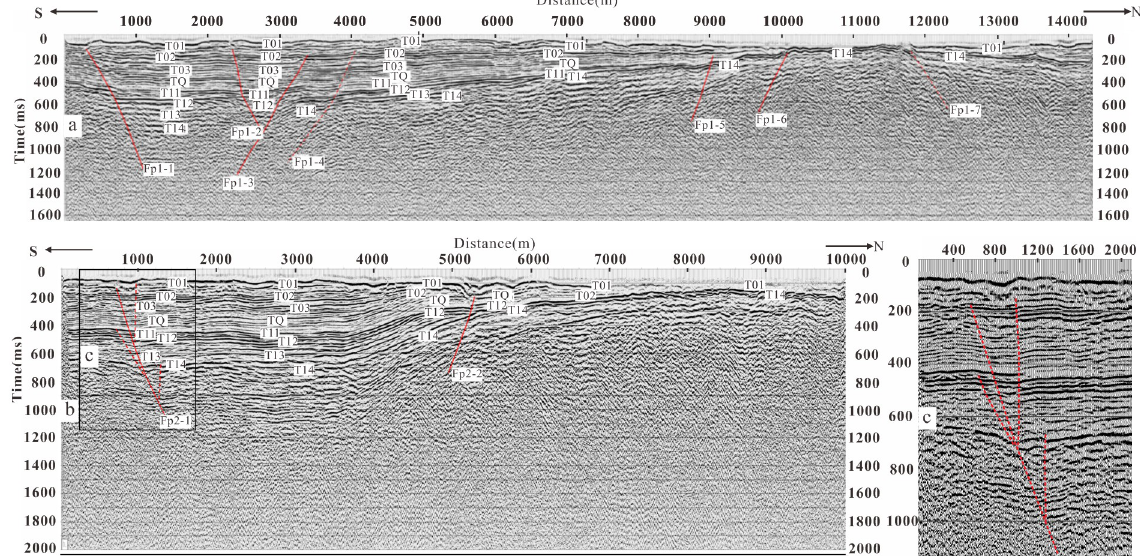
Fig 4. Seismic reflection time profile and geological interpretation of L1 and L2 exploration lines. (a) The seismic reflection migration time profile of the L1. (b) The time profile of the seismic reflection migration of the L2. (c) A local enlargement of the fault Fp2-1 in Fig 4b.